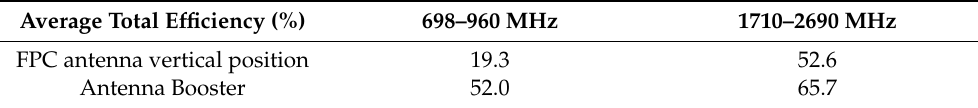
Figure 7. Measured total efficiency for the antenna booster and FPC solutions in Figure 6. Table 3. Measured total efficiency for the FPC and booster antenna . Average Total Efficiency (%)